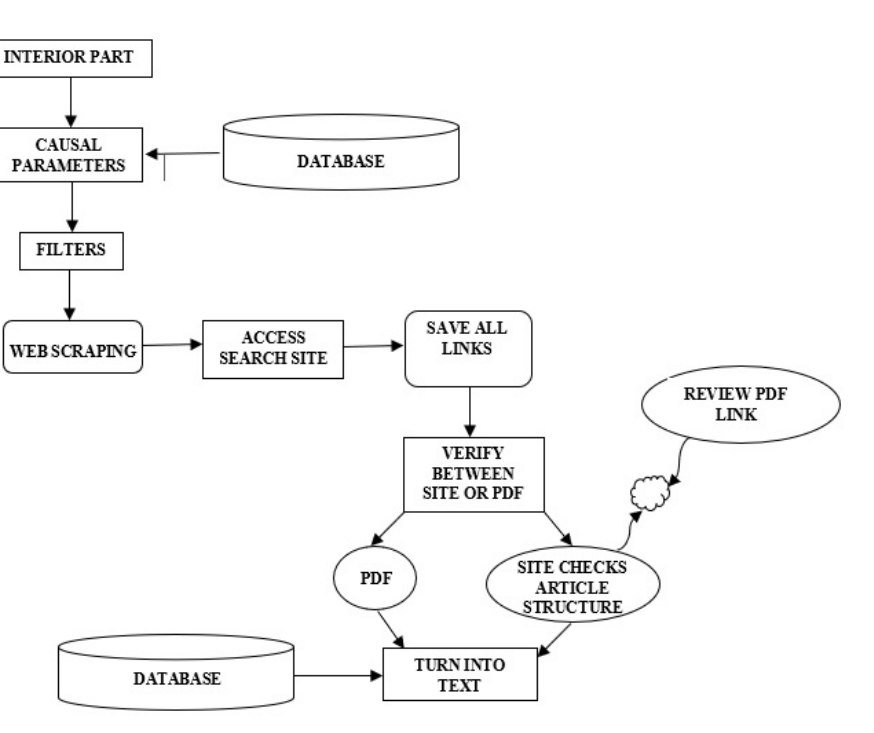
Figure 4. Structure of web